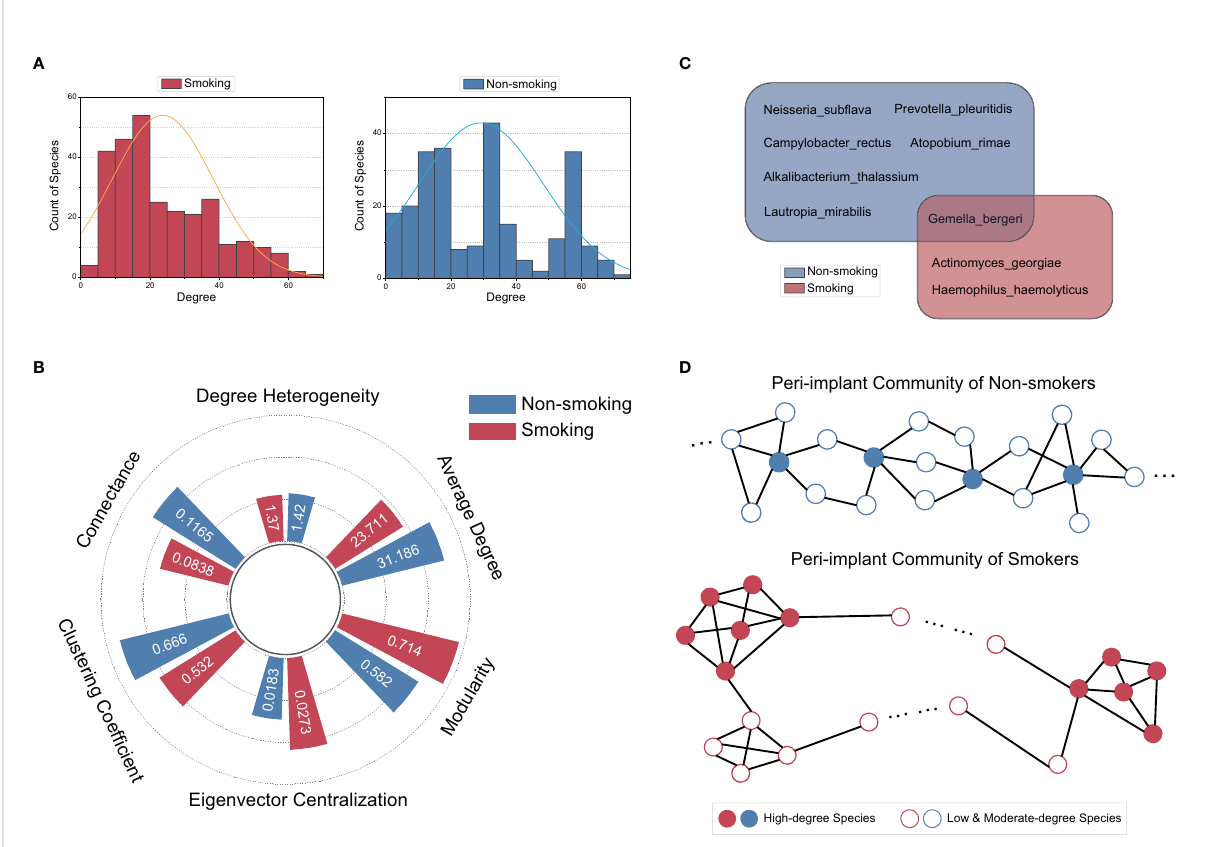
FIGURE 4 (A) Degree distribution of the smoking and nonsmoking communities. The fi tting curves of both groups demonstrate a right-skewed tendency. Especially in the smoking group, the number of high-degree species is very limited. (B) Analysis of topological properties. Smoking is associated with higher modularity and eigenvector centralization, and is also associated with lower clustering coef fi cient and density in the correlation network. (C) The articulation species in the two groups are shown in the Venn diagram. Articulation species referred to those bridging connectors between modules. (D) Based on the topological properties acquired, schematic diagrams are plotted to show the different patterns of how the species were connected in the two groups. In the nonsmoking group, all species are connected more proportionately than in the smoking group. The whole network is more evenly clustered, and there are more articulation species bridging the network. In the smoking group, high-degree species preferentially interact with each other, dividing the network into several modules. There are also fewer articulation species and a tendency toward less